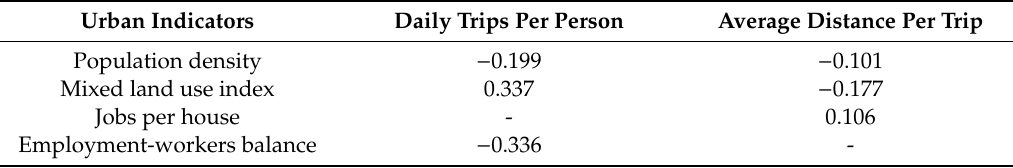
Table 8. E ff ects of new urban development on mobility pattern. Urban Indicators Daily Trips Per Person Average Distance Per Trip Population density − 0.199 − 0.101 Mixed land use index 0.337 − 0.177 Jobs per house - 0.106 Employment-workers balance − 0.336 - Source: